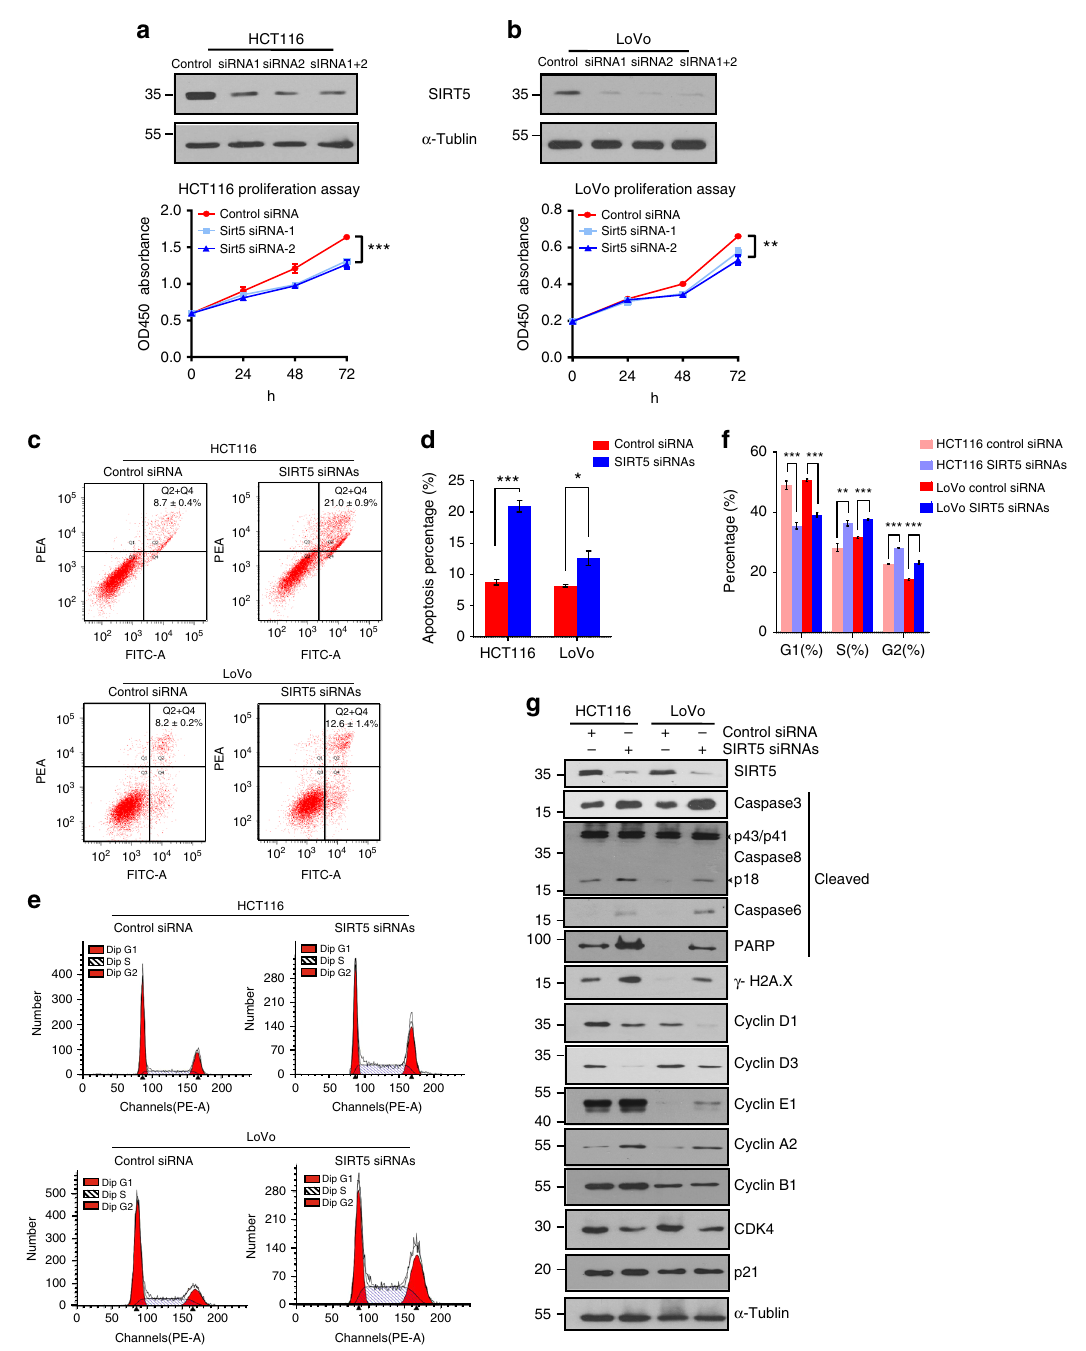
Fig. 2 SIRT5 is required for proliferation and regulates cell cycle and apoptosis in colorectal cancer cells. a , b Growth curves of HCT116 ( a ) and LoVo ( b ) cells transfected with two different SIRT5 short interfering RNAs (siRNAs; blue lines) or control siRNA (red line). Results are presented as mean ± SD of fi ve independent samples. ANOVA with Tukey ’ s test. Western blotting was performed to validate the knockdown ef fi ciency. c , d Flow cytometric assay based on phycoerythrin-conjugated Annexin V staining showing the increased apoptosis of HCT116 and LoVo cells at 48 h post transfection with SIRT5 siRNAs. Representative fl uorescence-activated cell sorting (FACS) images are shown in c . Data in c were quanti fi ed ( d ). e , f G2-M phase and S phase arrest were detected in SIRT5 -knockdown HCT116 and LoVo cells ( e ). Data in e were quanti fi ed ( f ). Results in d and f are presented as mean ± SD of three independent samples. Student ’ s t -test for d . ANOVA with Tukey ’ s test for f . * P < 0.05, ** P < 0.01, and *** P < 0.001. g Western blotting analysis showing increased levels of cleaved caspase 3, caspase 8, caspase 6, PARP, and γ H2AX, and altered levels of cell cycle regulators in SIRT5-silenced HCT116